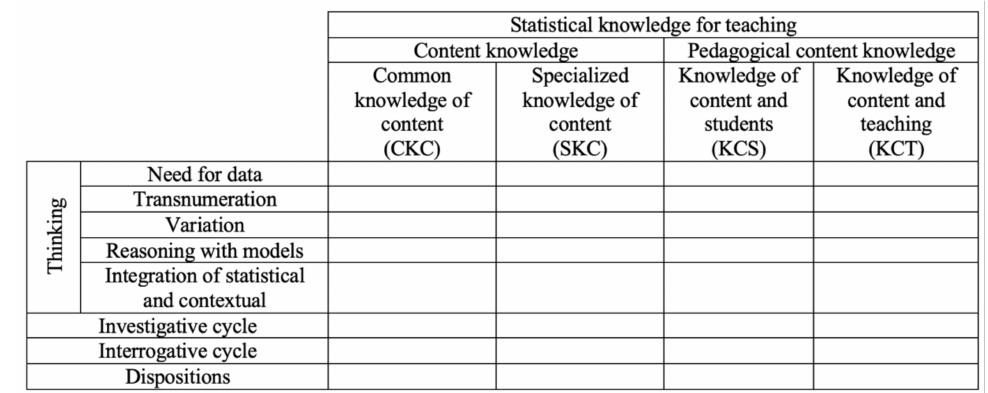
Figure 1. Components of the TKSI model [18] (p. 4). (Reprinted with permission from ref. [18]. Copyright 2006,